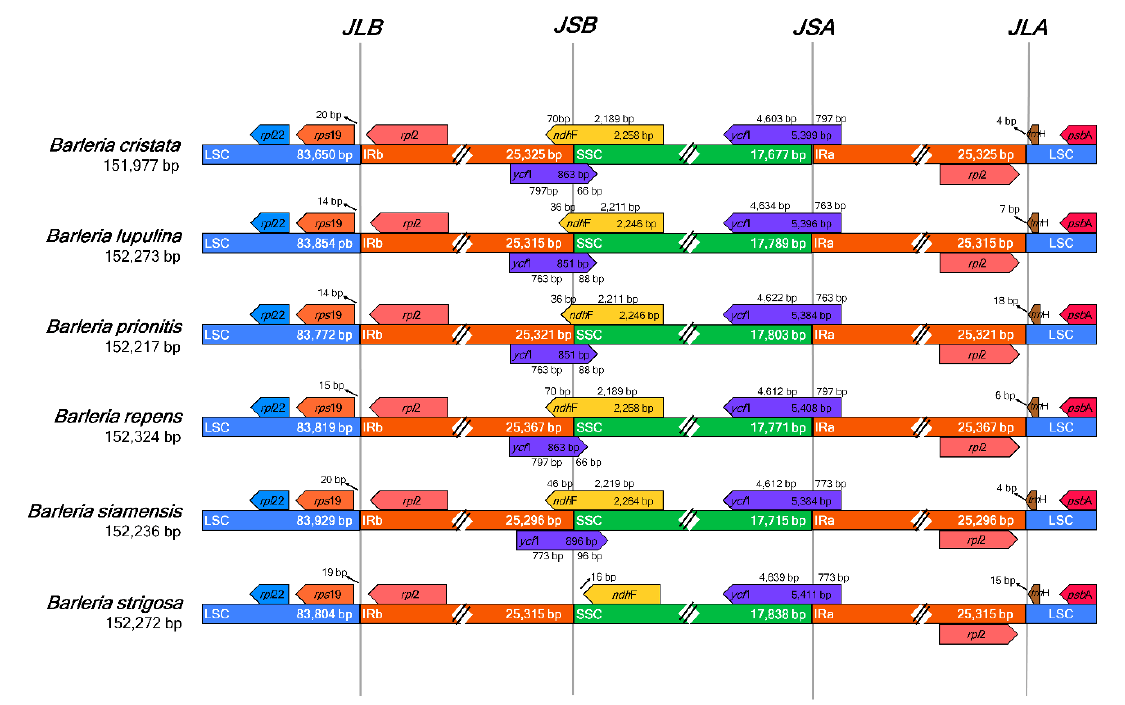
Figure 3. Comparison of the large single-copy (LSC), small single-copy (SSC), and a pair of an inverted repeat (IR) region borders of the six Barleria chloroplast genomes. The boxes below and above the lines indicate the adjacent border gene revealing the point differences as a shorter ndh F gene sequence and a lack of the ycf 1 gene in B. strigosa .